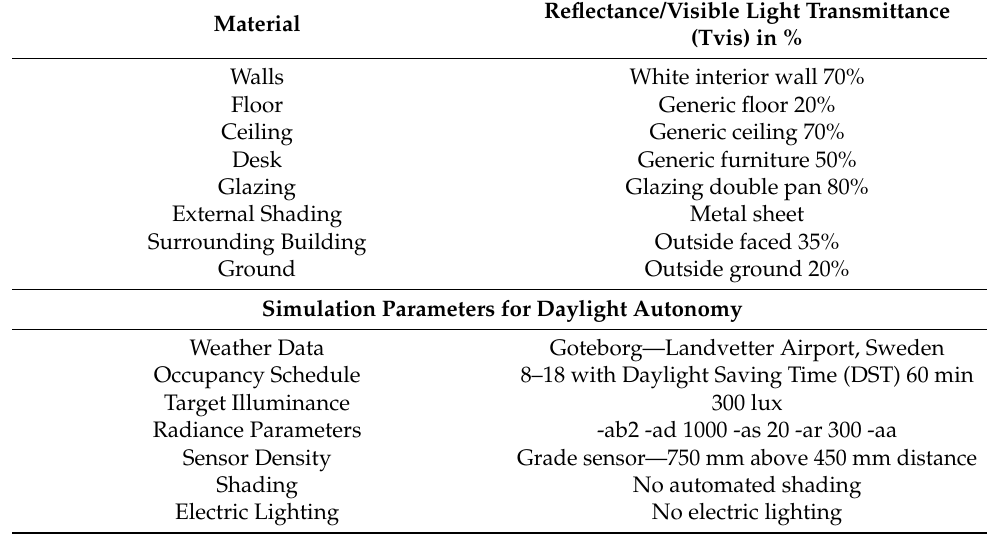
Table 4. Material properties and simulation